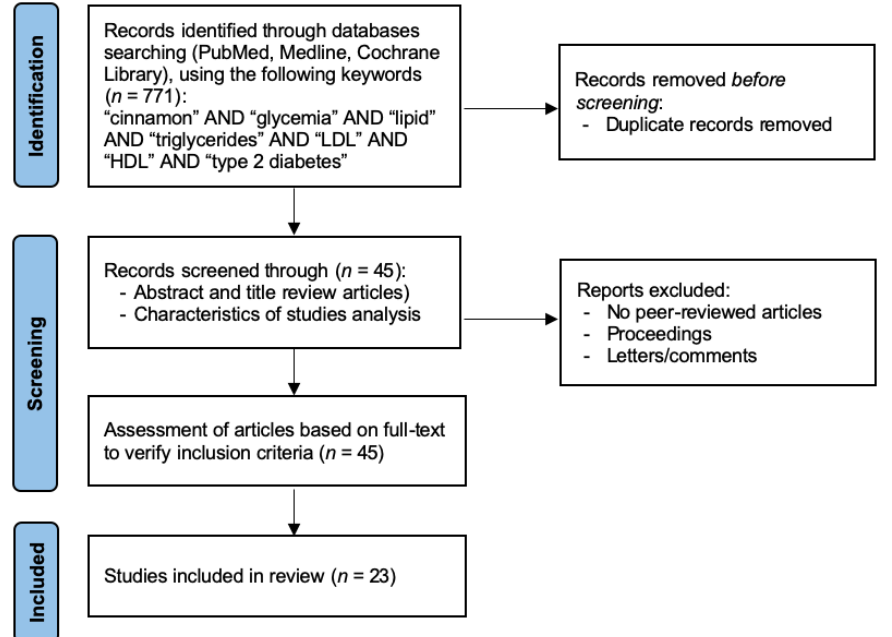
Figure 1. Flow diagram depicting the study selection process.